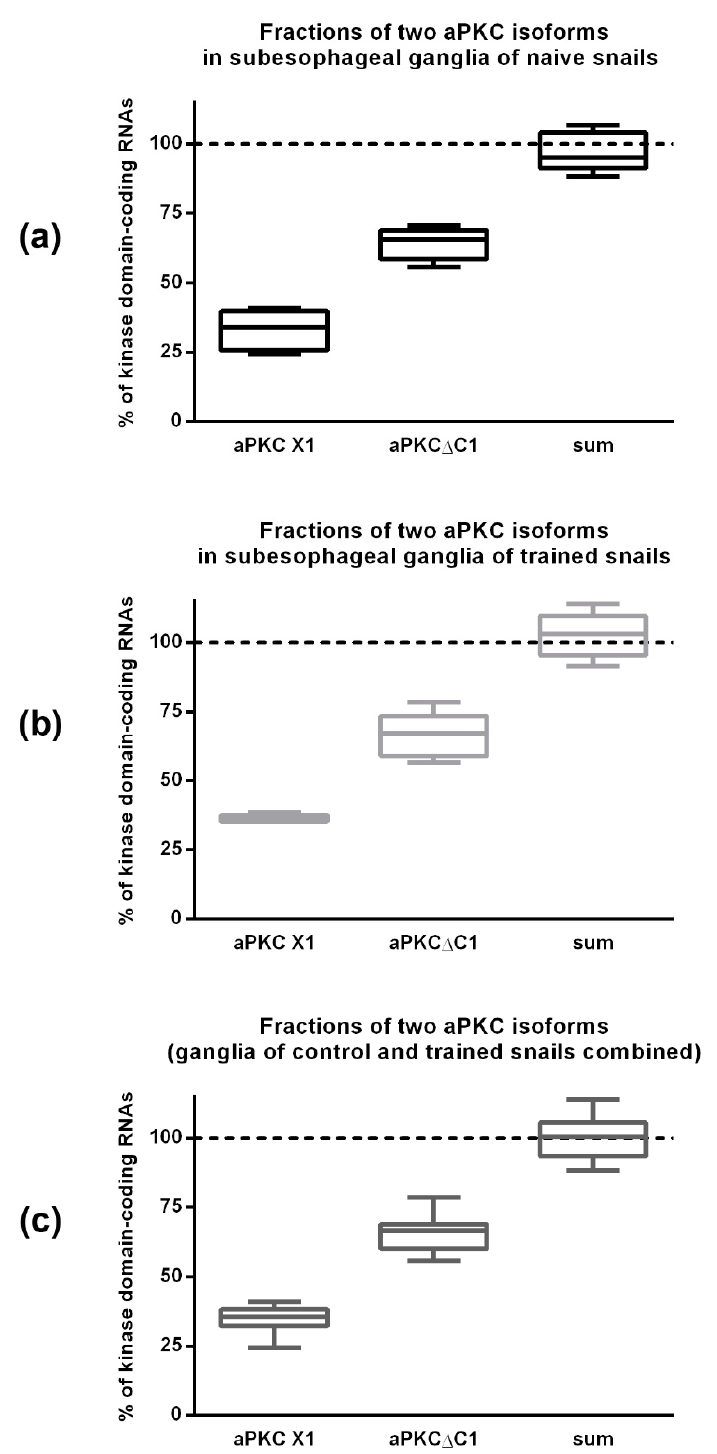
Figure 5. The number of cDNA fragments corresponding to different aPKC mRNA isoforms, normalized to the number of kinase domain-encoding cDNA fragments. The data was obtained by ddPCR using cDNA made from RNA extracted from subesophageal ganglia after contextual fear conditioning experiment. ( a ) Control (naive) snails, n = 5; ( b ) trained snails, n = 5; and ( c ) combined data for all 10 samples. Boxes represent median and quartiles; whiskers represent minimum and maximum values. Horizontal dotted lines mark 100% level. Sum–the total amount of aPKC Δ C1 and aPKC X1 molecules taken together.